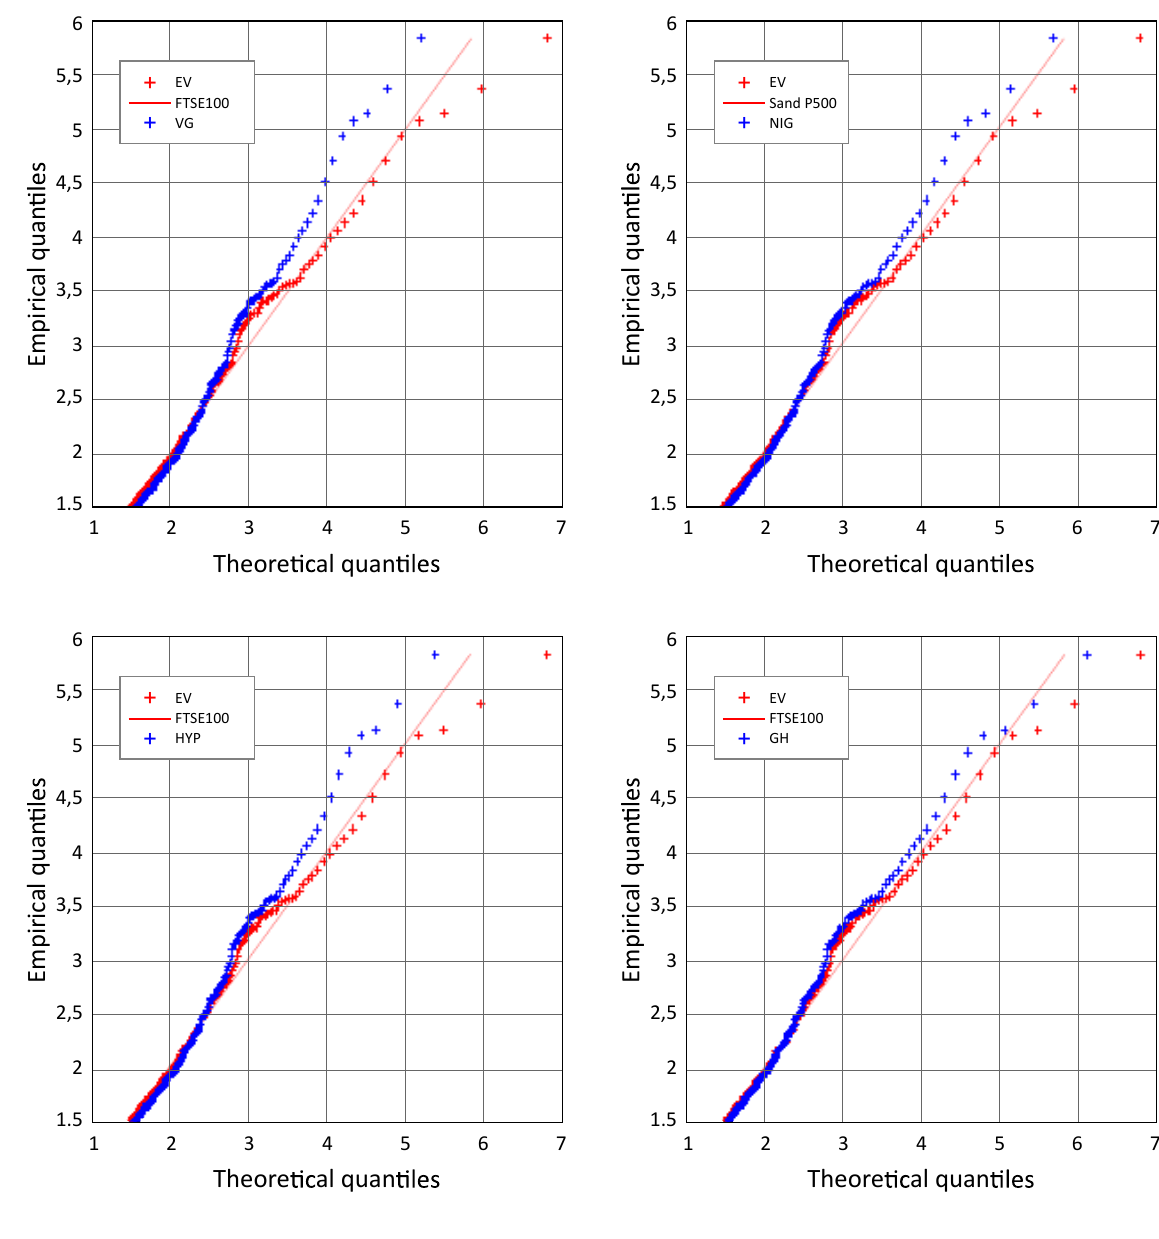
Figure 2. Conditional and unconditional quantiles in excess of threshold (1.5): long position in FTSE